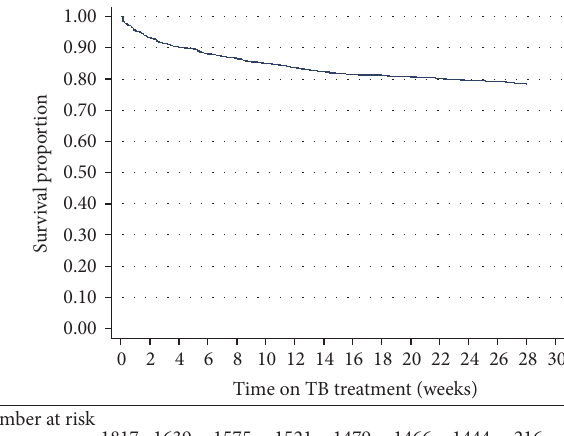
Figure 2: Overall Kaplan-Meier survival estimates among patients on TB treatment. TB = tuberculosis.